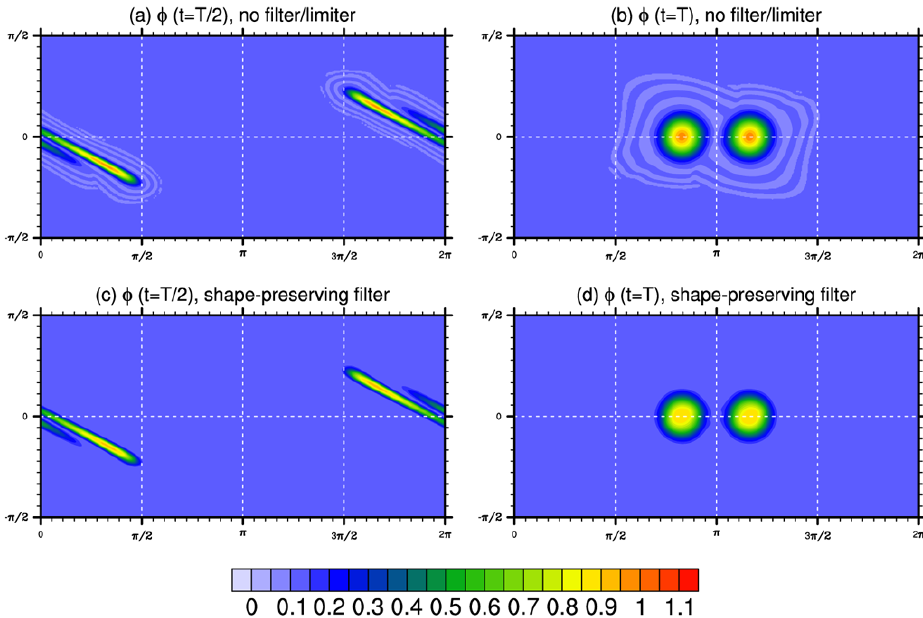
Fig. 9. Plotted as in Fig. 7 but for the divergent flow field ( 1t = T/ 120, resolution 1λ = 1 . 5 ◦ , and maximum Courant number is approxi- mately